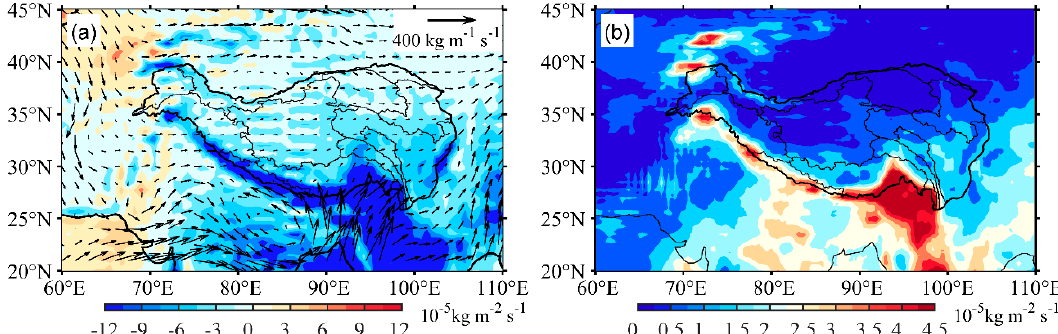
Figure 3. ( a ) Vertically integrated water vapor transport of the TP in summer, similar to Figure 2b and ( b ) mean square deviation of the water vapor flux divergence (unit: 10 − 5 kg m − 2 s − 1 ). From the perspective of the seasonal WVB distribution (Figure 4a), in spring, the high-value regions of the WVB are the Yarlung Zangbo River Basin (30.1%), the Indus River Basin (16.1%) and the Upper Yangtze River Basin (14.4%); in summer, the high-value regions of the WVB include the Yarlung Zangbo River Basin (33.7%), the Upper Yangtze River Basin (22.2%) and the Ganges River Basin (11.5%); in autumn (Figure 4b), the high-value areas of the WVB are the Upper Yangtze River Basin (37.3%), the Yarlung Zangbo River Basin (34.6%) and the Lancang River Basin (16.7%); in winter, the regions with high WVB are the Indus River Basin (48.3%), the Lancang River Basin (19.0%) and the AmuDarya River Basin (16.3%). We find that the high-value areas of the WVB are concentrated in the south, southwest and southeast of the plateau. Moreover, as the seasons change, the high-value center exhibits an east–west shift.